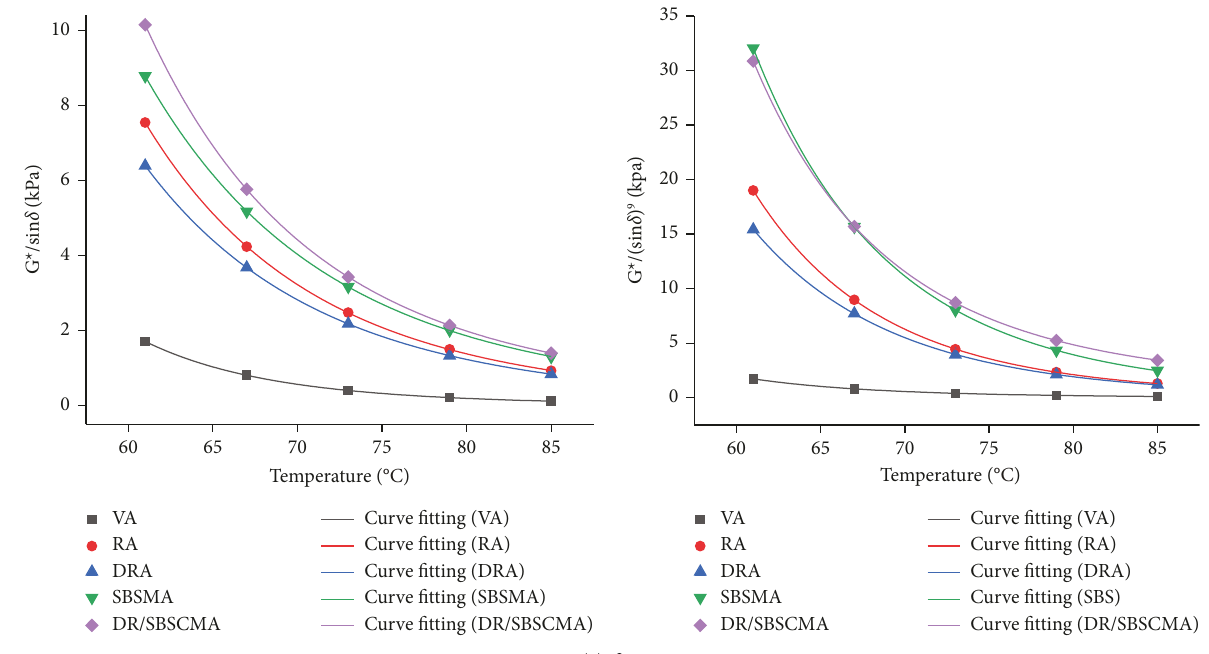
Figure 9: Equation (1) fitting regression curve.